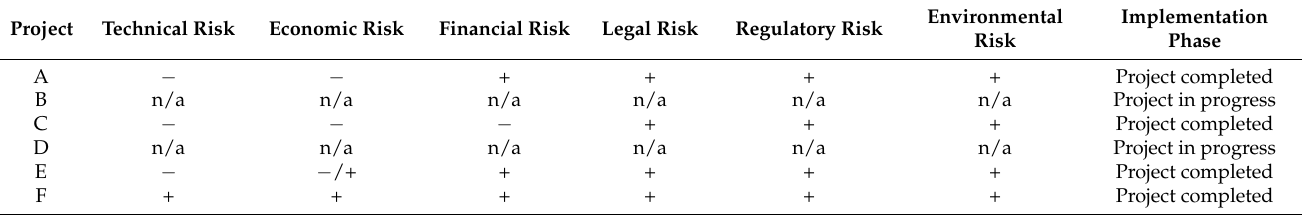
Table 12. Risks of CHP investment projects in the closure phase.